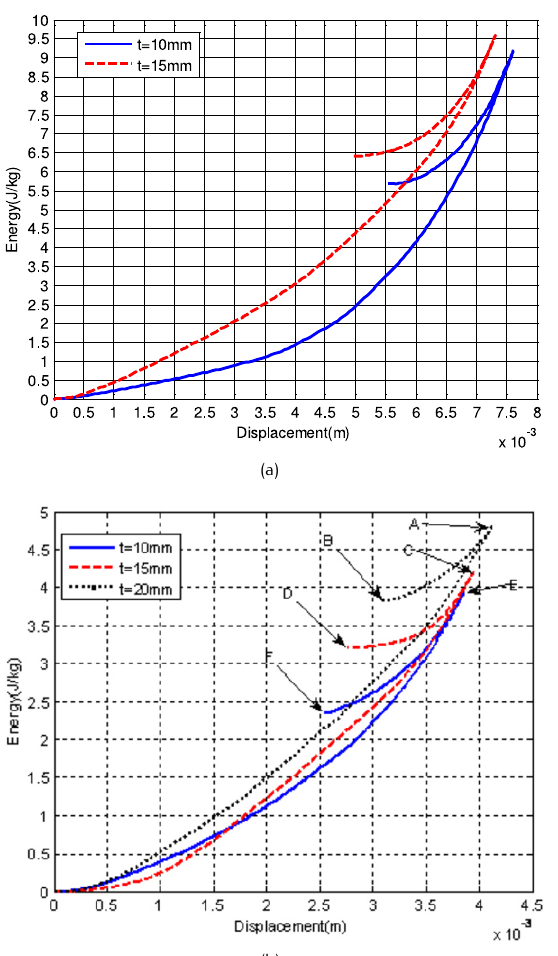
Figure 15. Absorbing energy versus displacement for crushable foams: (a) PUR; (b) EPP.